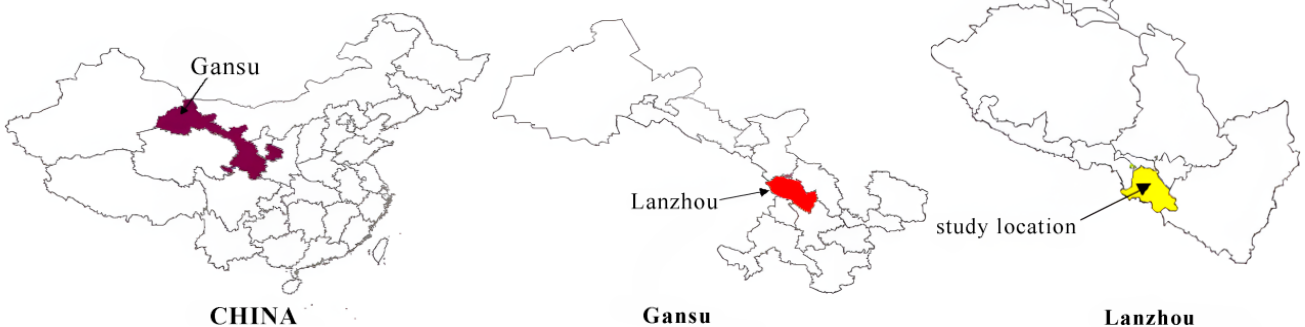
Figure 1. The location of experiment